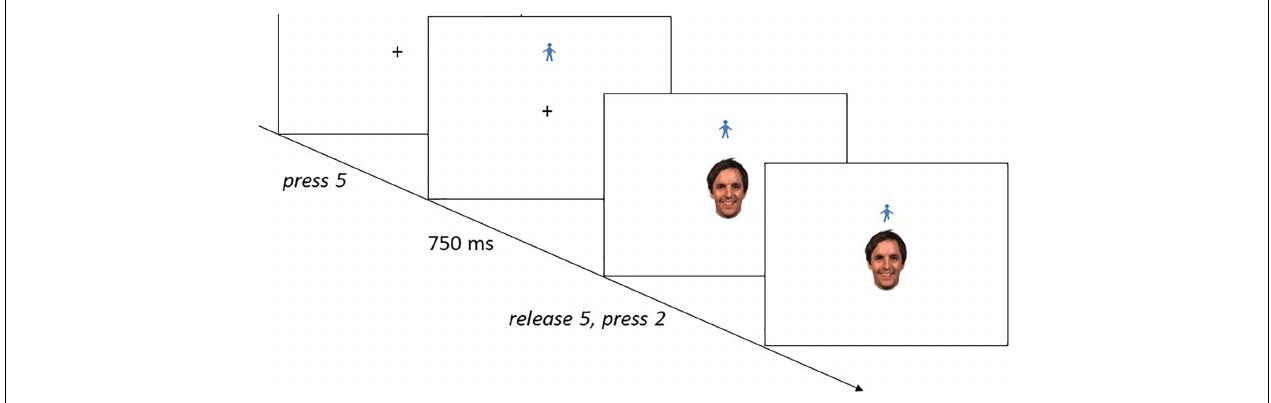
FIGURE 1 | An example of a trial sequence: The participant categorized the German face by moving the manikin toward the face (only the first approach step is shown, see text for further explanations). Facial images sourced from: Paulus et al. (2011). Reproduced with permission.